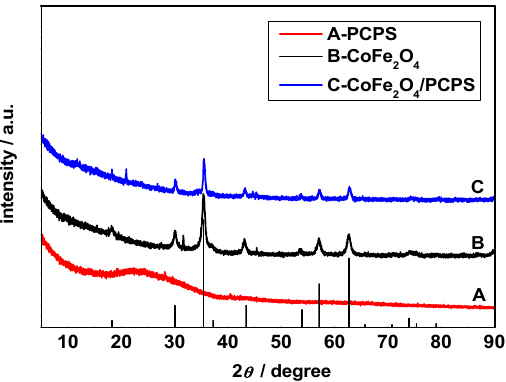
Figure 3. XRD patterns of synthesized PCPS ( A ), CoFe 2 O 4 ( B ), and CoFe 2 O 4 /PCPS ( C ).